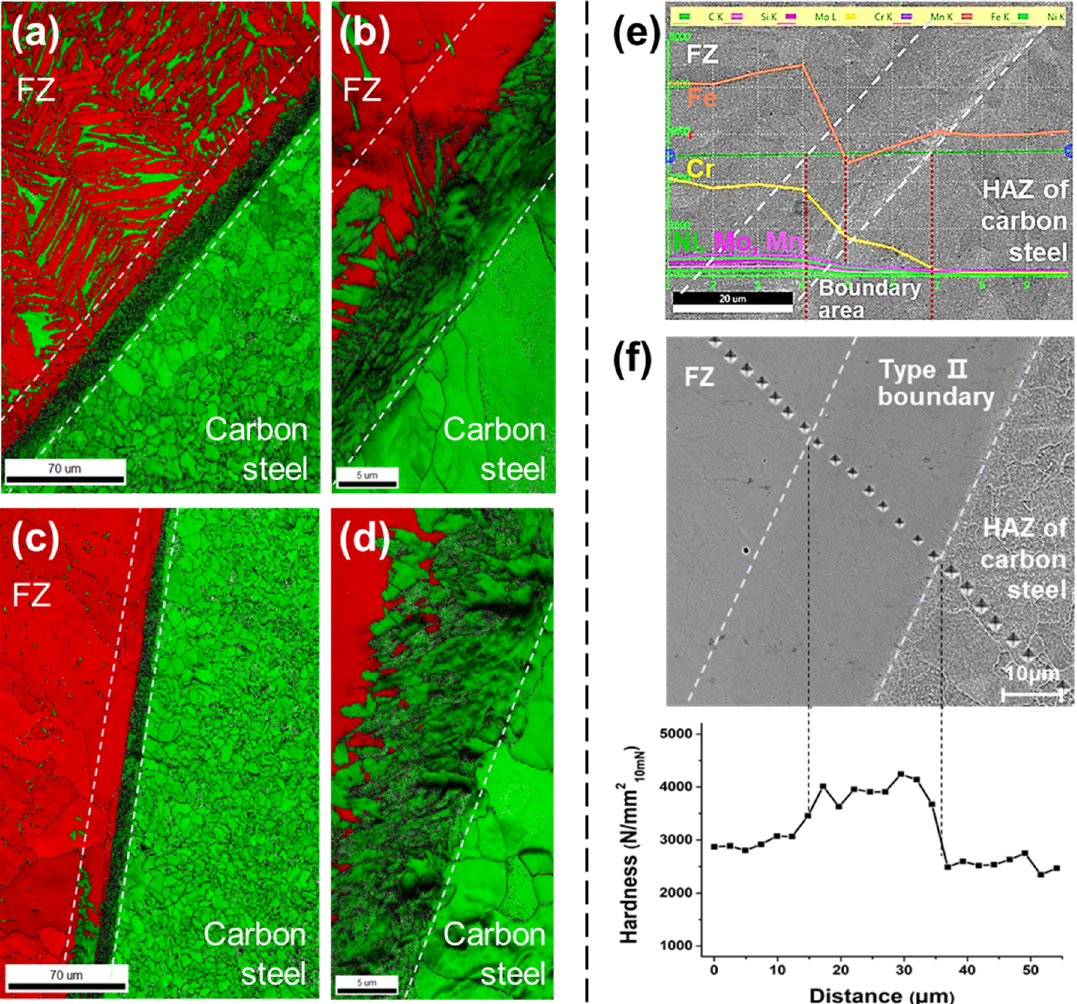
Figure 8. Electron back-scattered diffraction (EBSD) phase maps of the type-II boundary in the ( a , b ) DF and ( c , d ) AF. The red and green colours in the phase maps indicate the austenite and ferrite phases, respectively. ( e ) Energy-dispersive X-ray spectroscopy line map and ( f ) nanoindentation across the type-II boundary of the AF. The white-dashed lines indicate the type-II boundary region.